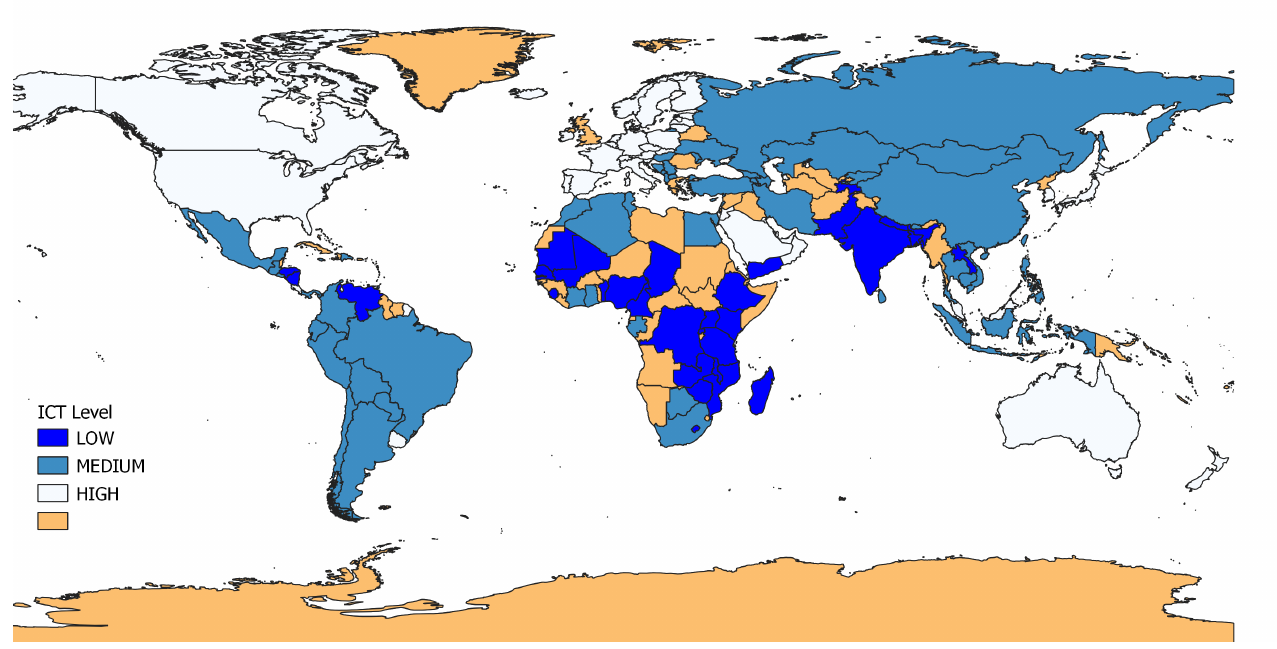
Figure 2. Map of countries by ICT